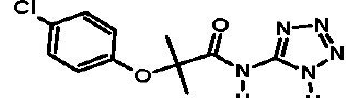
Figure 2. Chemical structure of 2-(4-chlorophenoxy)-2-methyl- N -(1 H -tetrazol-5-yl) propanamide (tetrazole analog of clofibric acid) (Compound 1 ).